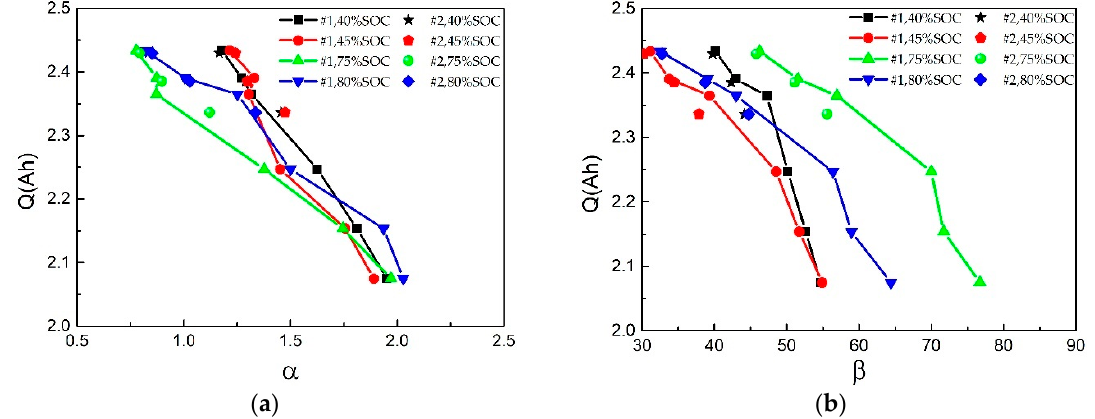
Figure 13. Relationship between relaxation voltage model parameters and capacity at 40%, 45%, 75%, and 80% SOC under discharging condition of cell #1 and #2. ( a ) results of α ; ( b ) results of β .